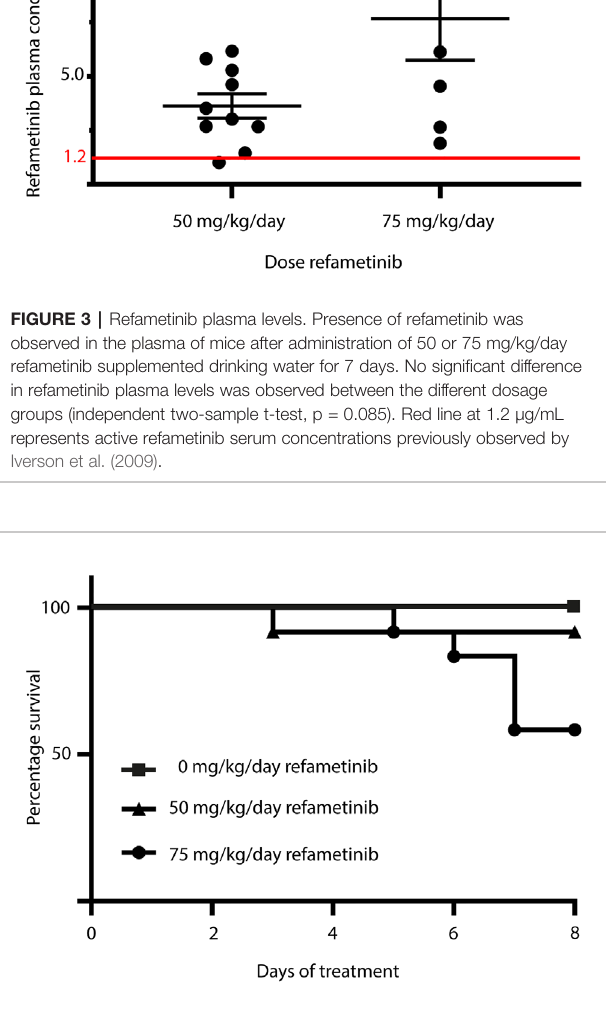
FIGURE 4 | Survival rate within each refametinib dosage group. One mouse out of 16 died during treatment with 50 mg/kg/day refametinib. Five out of 12 mice died during treatment with 75 mg/kg/day